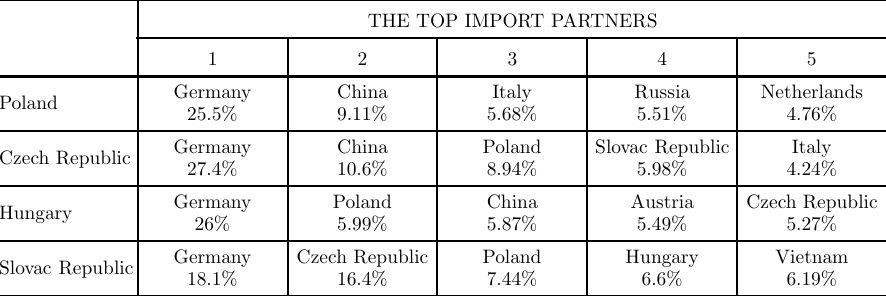
The top export partners of V4, %, share of total import THE TOP IMPORT